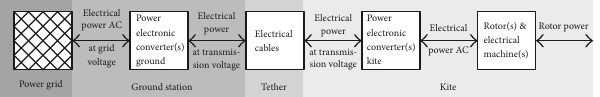
Figure 6: Block diagram of a generalized power electronic system of a drag power kite.